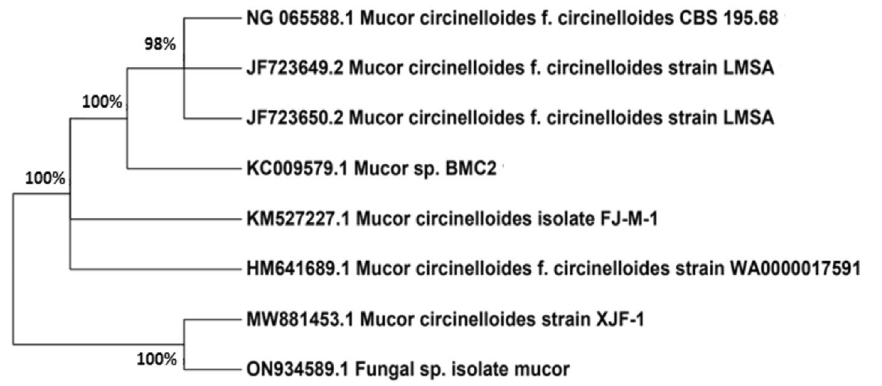
Figure 2. Phylogenetic tree of the fungal isolate Mucor